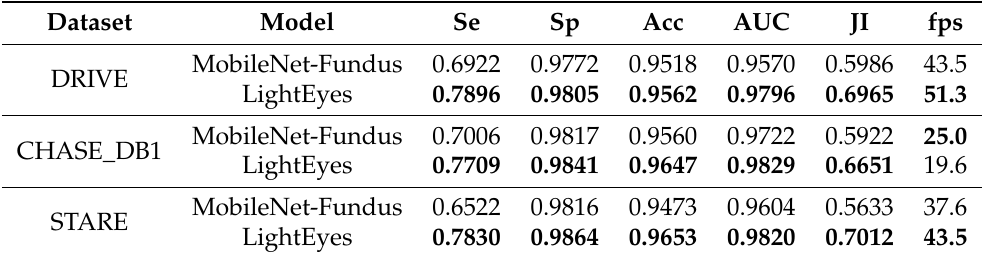
Table 9. Comparison with MobileNet on vessel segmentation (Best results are bold).